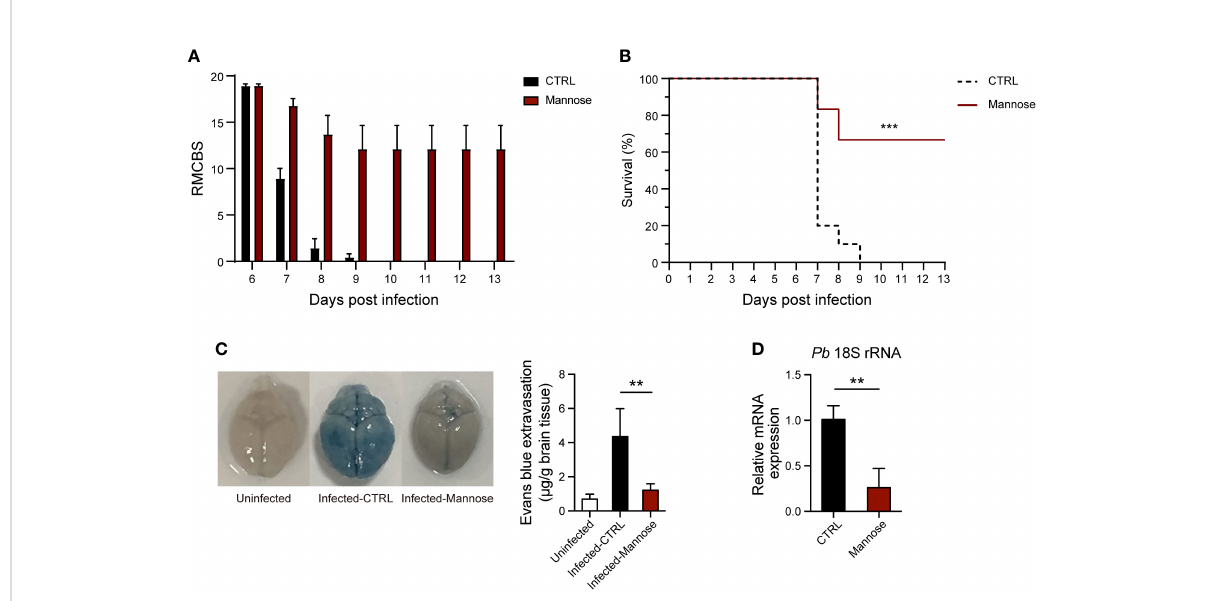
FIGURE 2 Mannose inhibits ECM development and parasite sequestration in the brain. (A) C57BL/6 mice infected with P. berghei were evaluated daily from day 6 post-infection (p.i.) using the RMCBS (n = 10-12/group). Scores signi fi cantly declined when the mice developed ECM. (B) D-mannose treatment signi fi cantly inhibited cerebral malaria development. CTRL vs. Mannose (+): P < 0.001 (Log-rank test). (C) Mannose treatment protected BBB integrity. Left: Representative images of brains from mice injected with Evans Blue to detect BBB leakage. Right: Quanti fi cation of Evans Blue dye in brains of mice in three groups (n = 3-5/group). (D) Mannose treatment inhibited parasite sequestration in the brain. Relative P. berghei 18S rRNA expression in the brain was determined by real-time PCR 7 days p.i. (mouse b -actin as internal control, n = 4/group). Data are presented as mean ± SD and were analyzed by the Kruskal-Wallis ANOVA. ** P < 0.01, *** P <